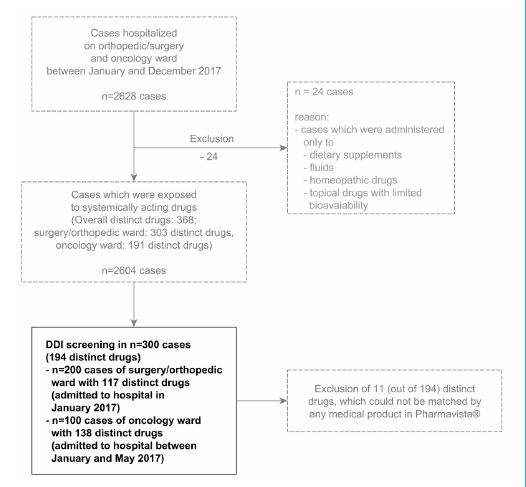
Figure 1: Selection of 300 patient cases for drug-drug interaction (DDI) screening. Cases were selected chronologically, starting from January